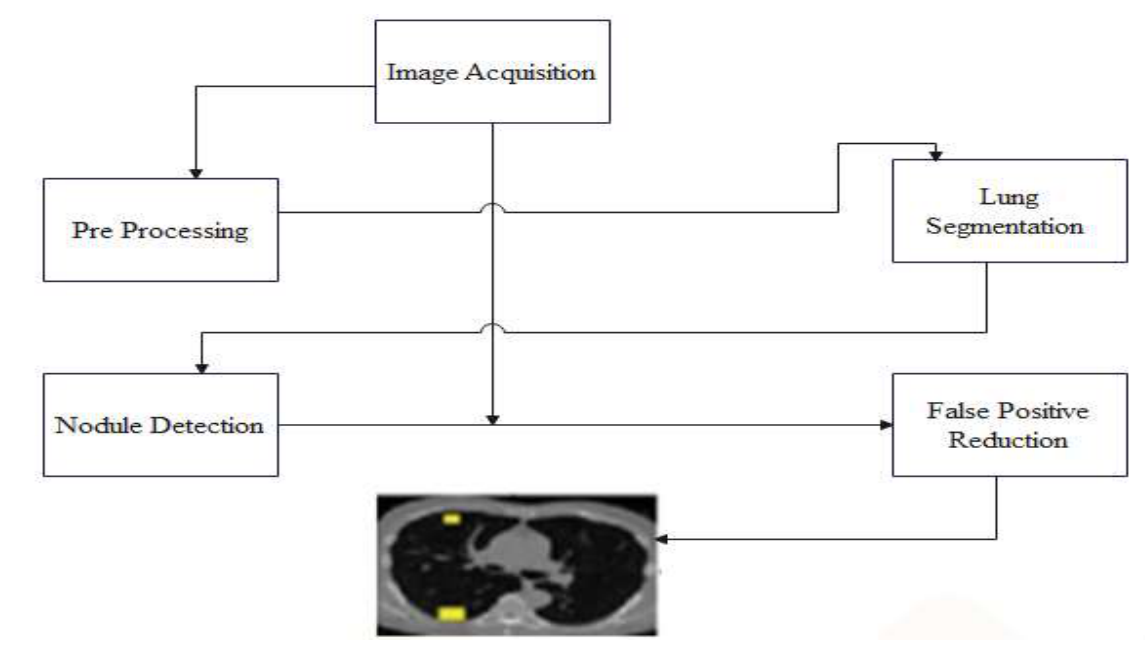
Figure 3. Lung nodule identification using a generic module.